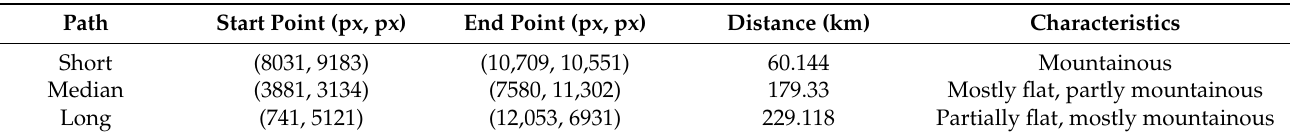
Table 2. Detailed information of the three path planning